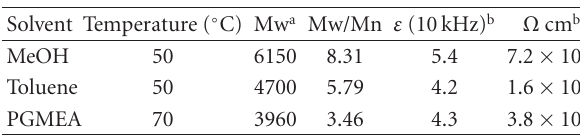
Table 1: Properties of PMSQ prepared in di ff erent